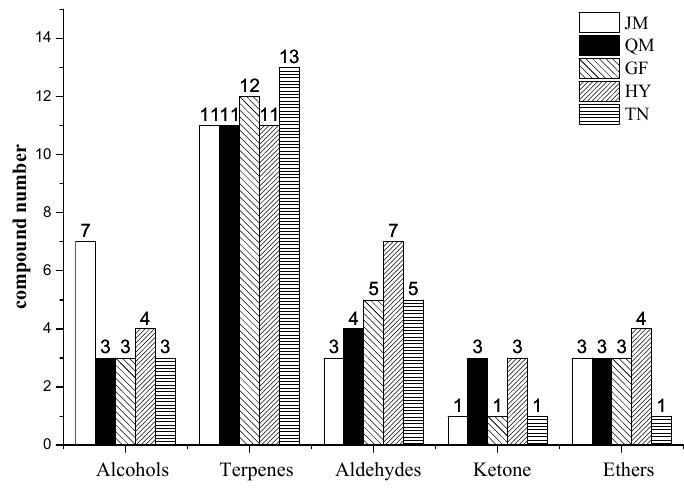
Figure 2. The representative Total ion chromatograms of five varieties mango samples. a : QM, b : JM, c : HY, d : TN, e : GF.